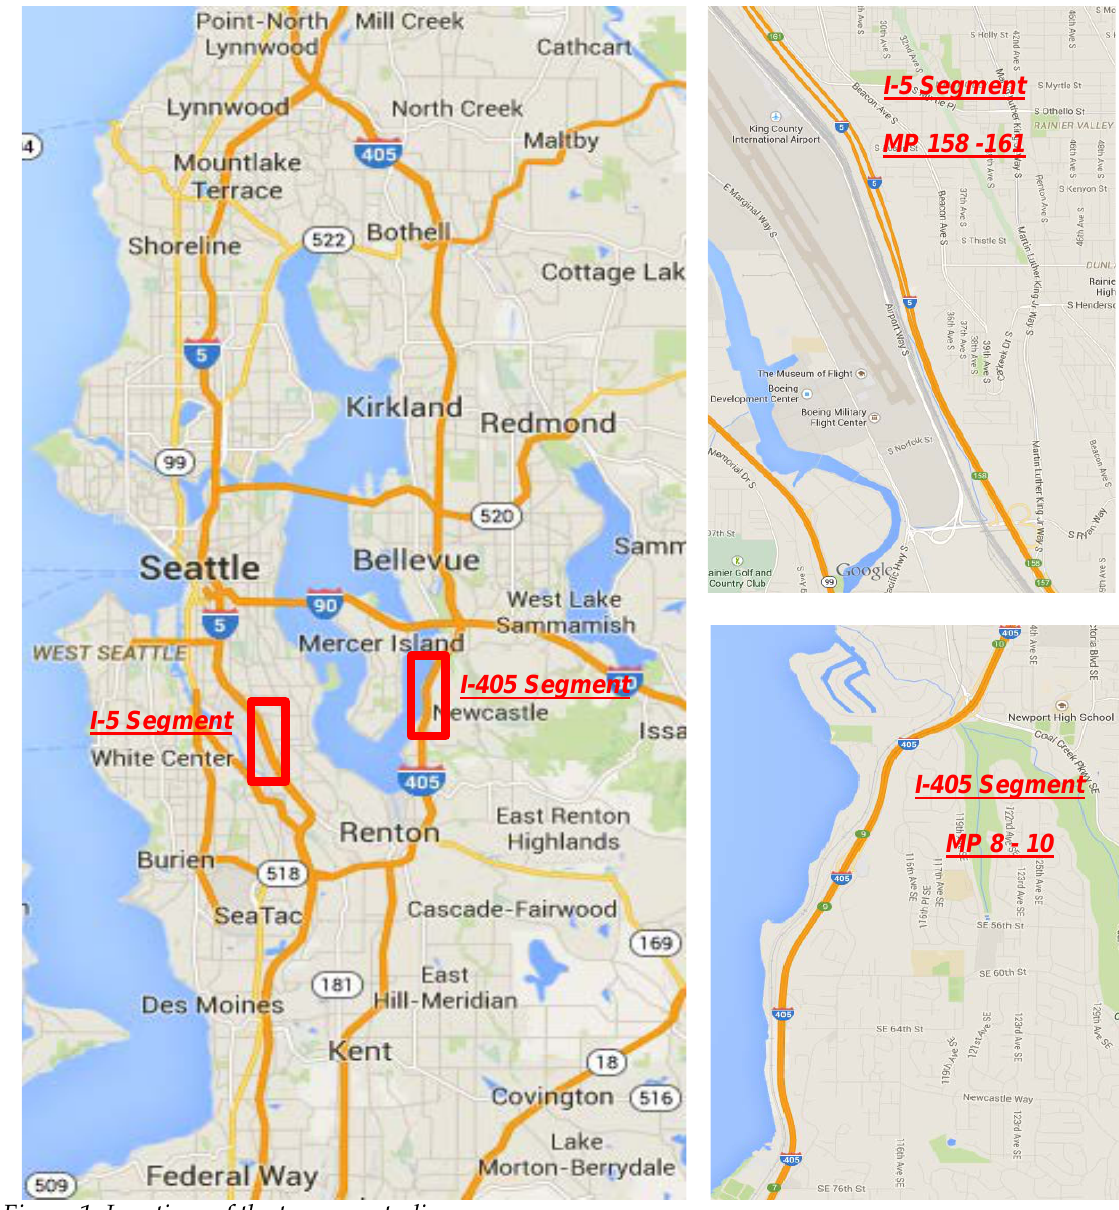
Figure 1. Locations of the two case studies Truck